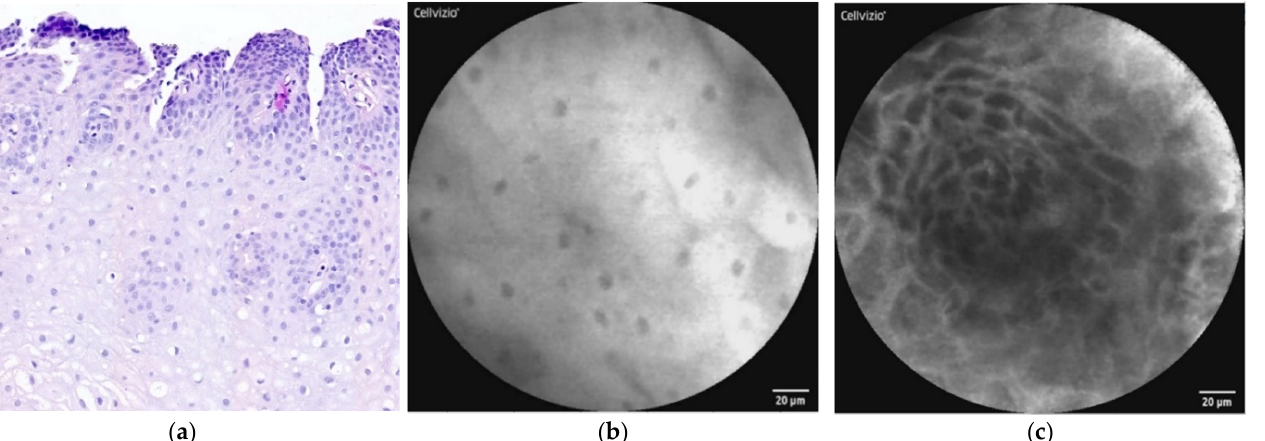
Figure 2. ( a ) Histopathology: nondysplastic BE with intestinal metaplasia of the esophageal epithe- lium, cylindrical unciliated epithelium with goblet cells. Without dysplastic changes. Hematoxylin– eosin staining. ( b ) pCLE view: intestinal metaplasia of the esophageal epithelium, columnar cells with dark goblet cells.